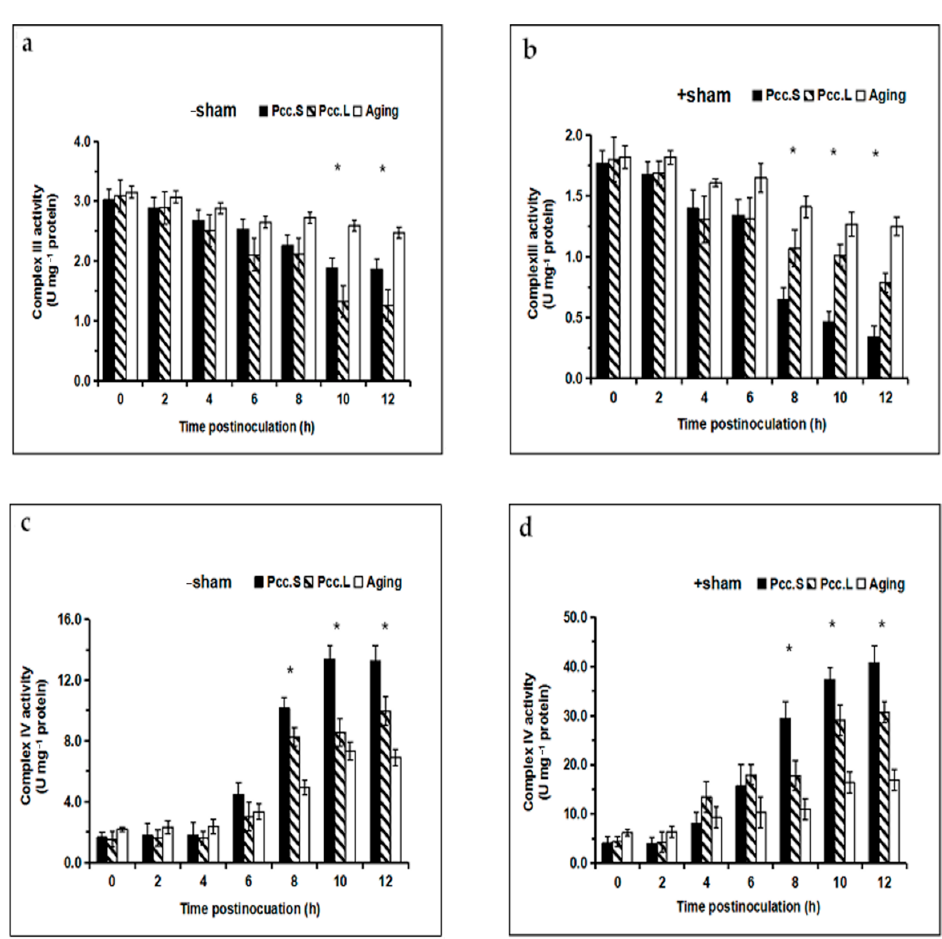
Figure 4. Effect of Pcc .L and Pcc .S treatment on mitochondrial complex III and complex IV activity of tuber slices in the no salicylhydroxamic acid treated group ( a , c ) and those of the salicylhydroxamic acid pretreated group ( b , d ). Aging indicates naturally aged potato tuber slices as control. Bars with * ( t -test) were significantly different at p < 0.05 between Pcc .S and Pcc .L. The standard errors (Vertical bars) of three replicates are shown.